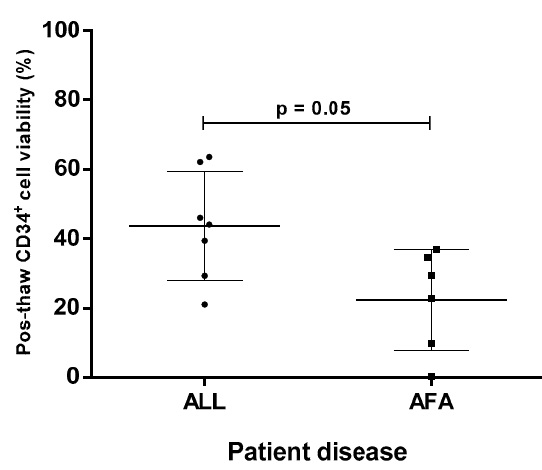
Figure 2. Comparison of CD34 + cell viability percentage from confirmatory testing after distal segment thawing. Seven umbilical cord blood (UCB) units matched with the acute lymphoblastic leukemia (ALL) patient and six UCB units matched with the aplastic / Fanconi anemia patient (AFA) patient. All units exhibited a 4 / 6 or 5 / 6 HLA match considering the three-locus algorithm (HLA-A, HLA-B, HLA-DRB1).